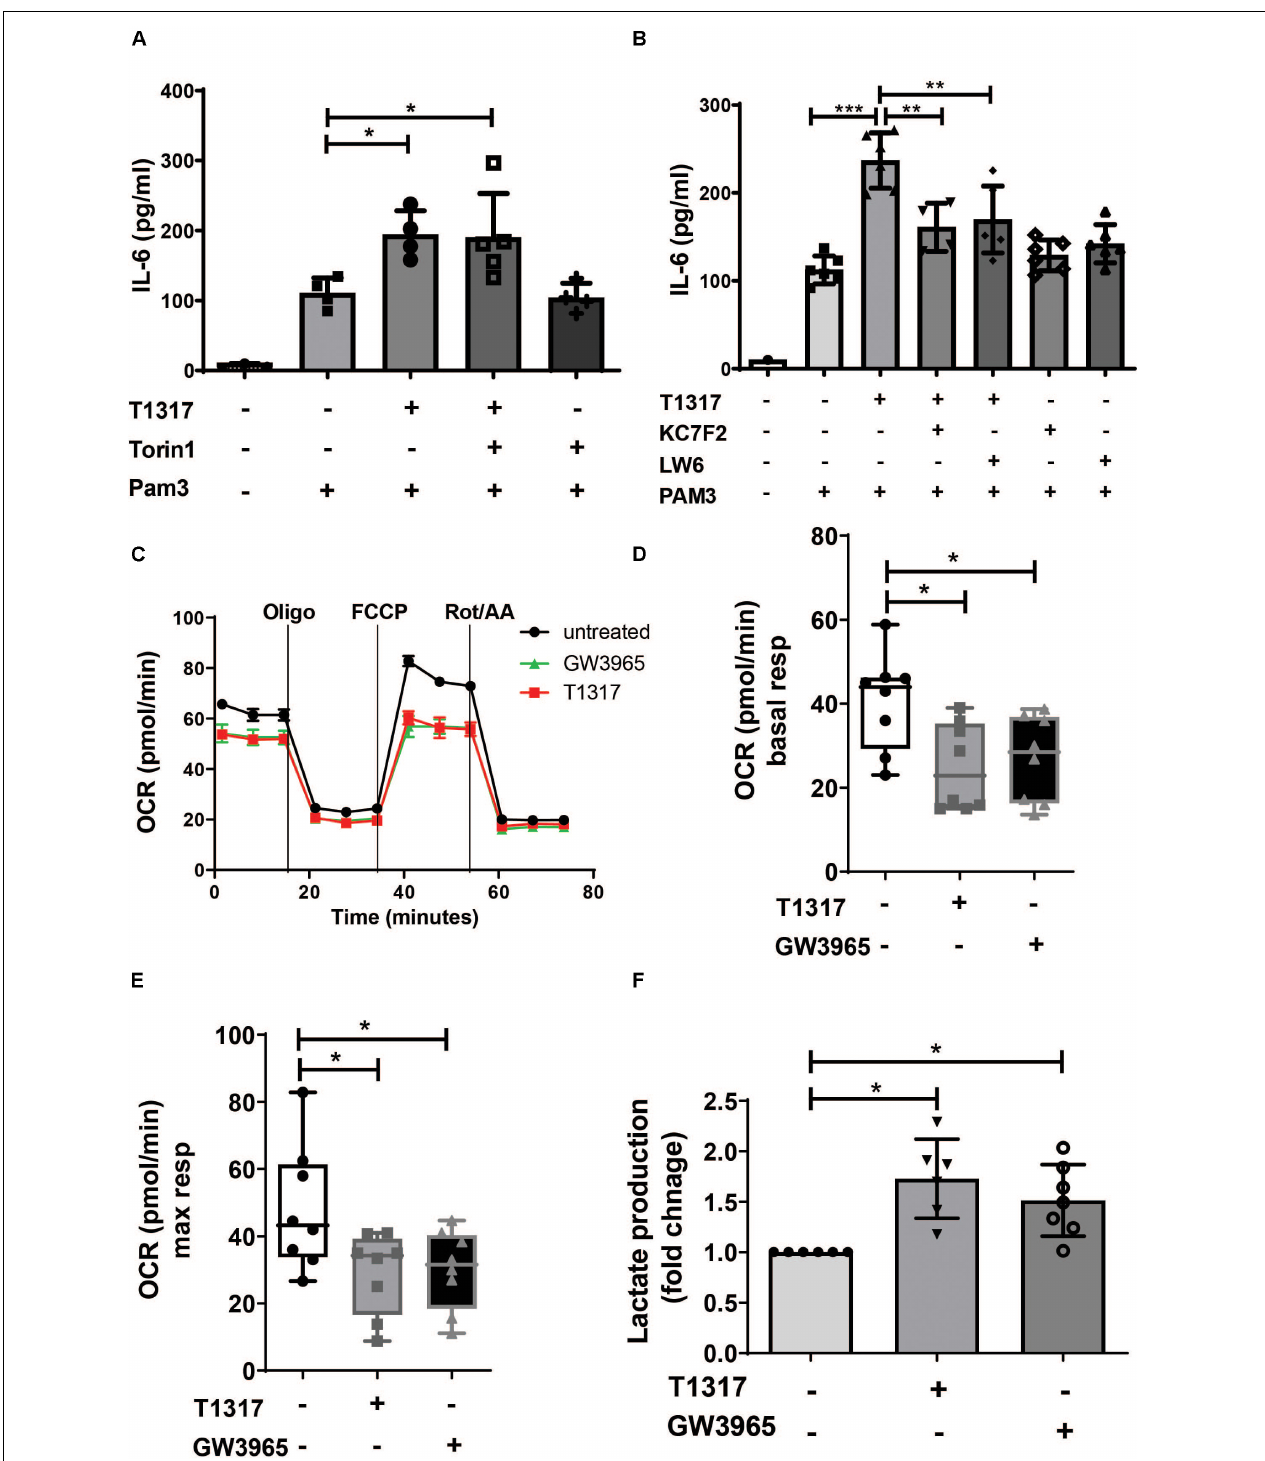
FIGURE 3 | LXR priming induces metabolic reprogramming in trained human monocytes. Monocytes were treated as indicated with 2 µ M T1317 (LXR agonist), 10 µ M GW3965 (LXR agonist), 100 nM Torin1 (mTOR inhibitor), 10 µ M LW6 (HIF1 α -Inhibitor), 10 µ M KC7F2 (HIF1 α -Inhibitor) or vehicle for 24 h and kept for 5 days in complete medium. (A,B) Cells were restimulated with 5 µ g/ml Pam3cys for 24 h and IL-6 was measured in the supernatant. (C) Oxygen consumption rate (OCR) of trained cells was determined on day 6. (D,E) Graphs depict mean basal (D) and maximal respiration (E) . (F) On day 6 cells were lysed and lactate concentration was measured. Graphs represent mean values ± SD of six individuals in three different experiments. * P < 0.05, ** P < 0.01, and *** P < 0.001.